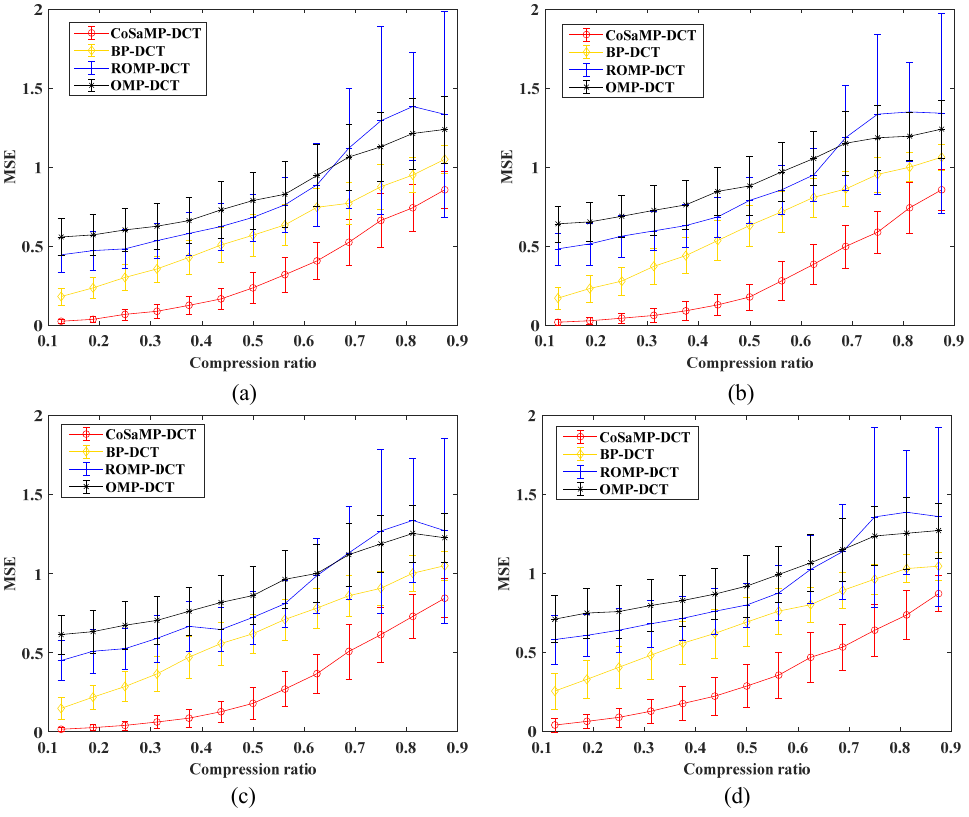
Figure 8. Compare and analyze the 95% confidence interval of MES on the four datasets with other compression reconstruction algorithms: ( a ) normal status, ( b ) ring gear, ( c ) planet gear, and ( d ) sun gear.